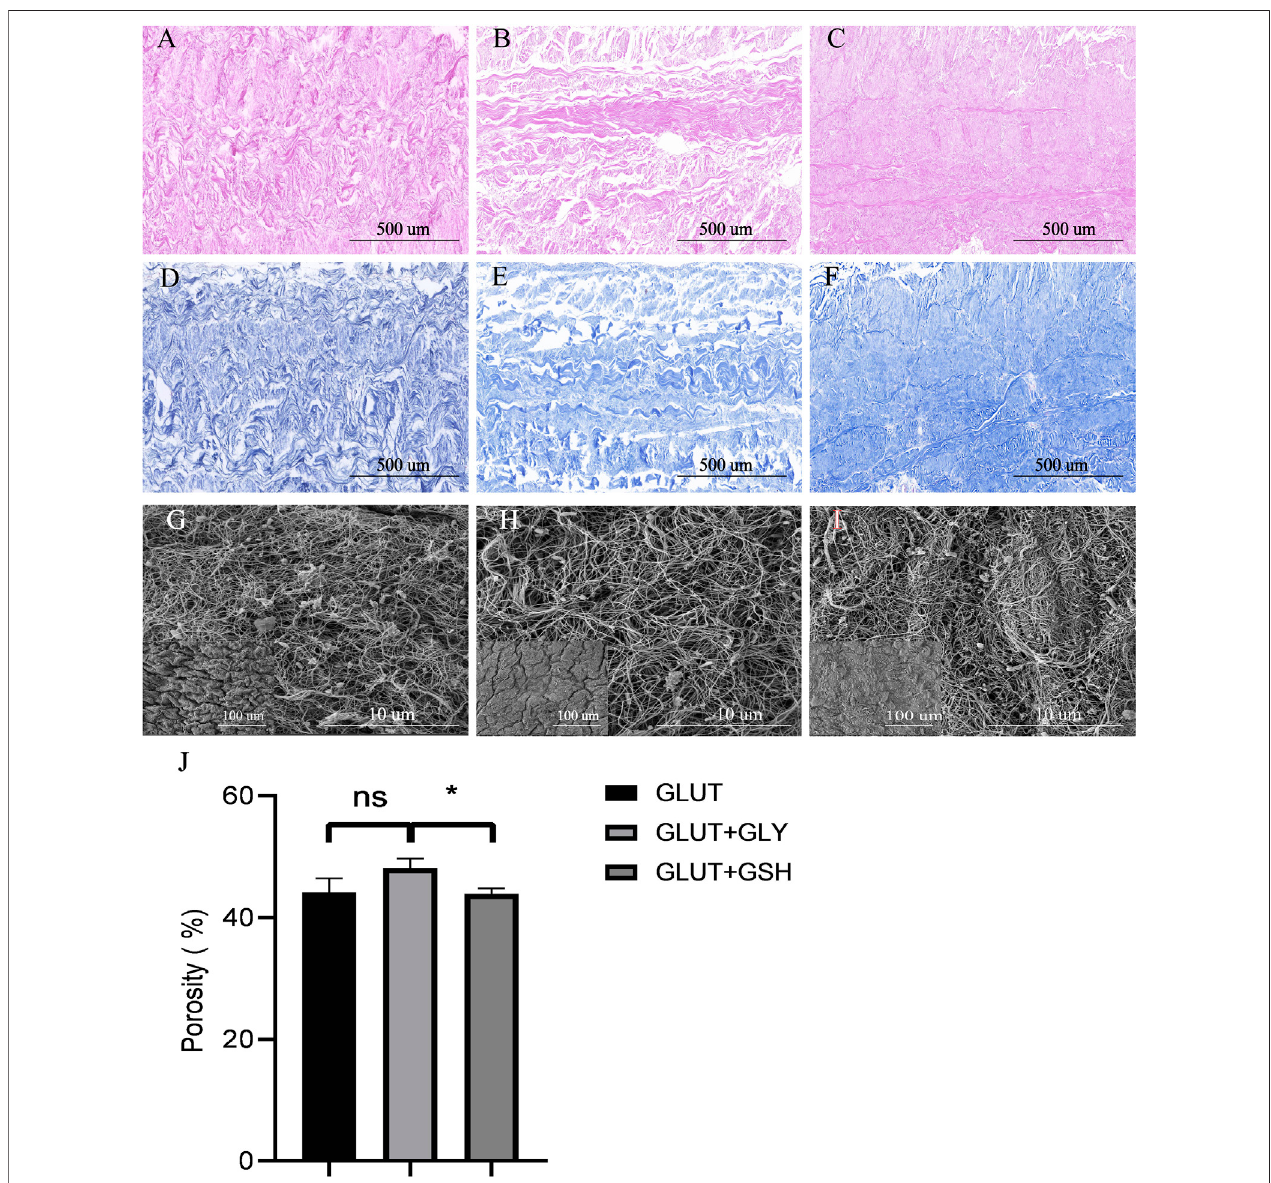
FIGURE4| Histologicalstaining(HEstaining 、 Massonstaining)andSEMforECMevaluationofBPsfromGLUT-BP (A,D) ,GLUT+GLY (B,E) ,GLUT+GSH (C,F) , The black bar indicates 500 um. The (G,H,I) is the SEM of GLUT (A) , GLUT + GLY (B) , GLUT + GSH (C) respectively, Each group shows a large picture (10.0kv, Scale bars = 10um) and a small picture on the bottom left corner (1.0kv, Scale bars = 100um). (J) is the porosity of BPs from each group ( n = 4; p p < 0.05; pp p < 0.01; ppp p < 0.001; ns represents no signi fi cant difference).